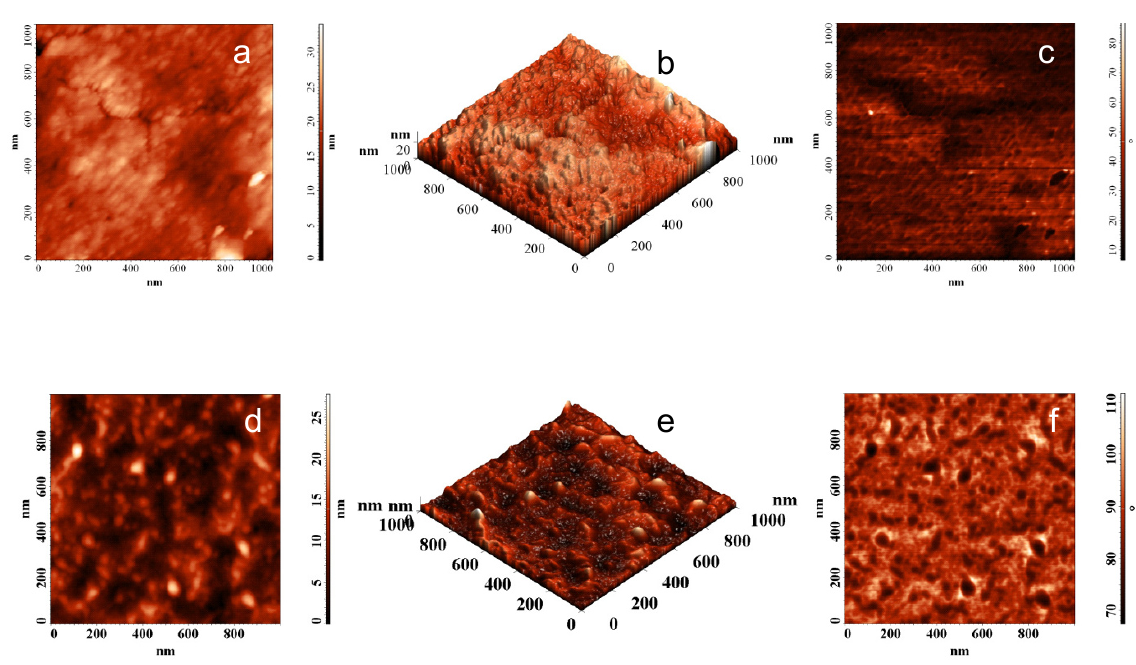
Figure 2. AFM images (2D, 3D and phase, respectively) of the SilAg precursor (a-c) and Sil1 precursor